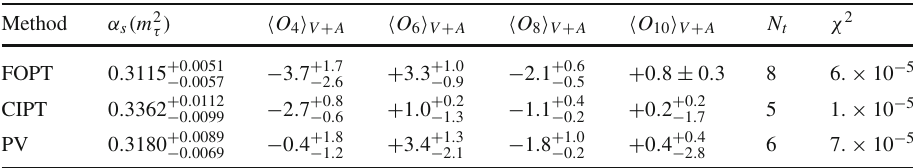
Table 5 As Table 4, but now (cid:12) O (cid:13) V + A is included in the 10 global fit. The condensates (cid:12) O (cid:13) D V + A are presented in units of 10 3 GeV